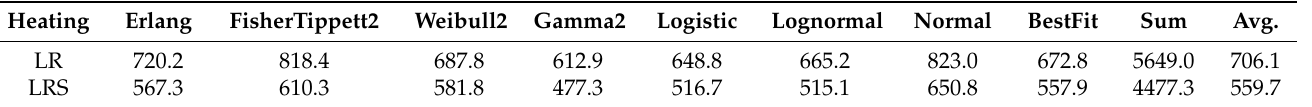
Table 2. Results of the mean absolute errors of heating energy use probability density functions stemming from each input average annual weather variable distribution series for LR and LRS regression